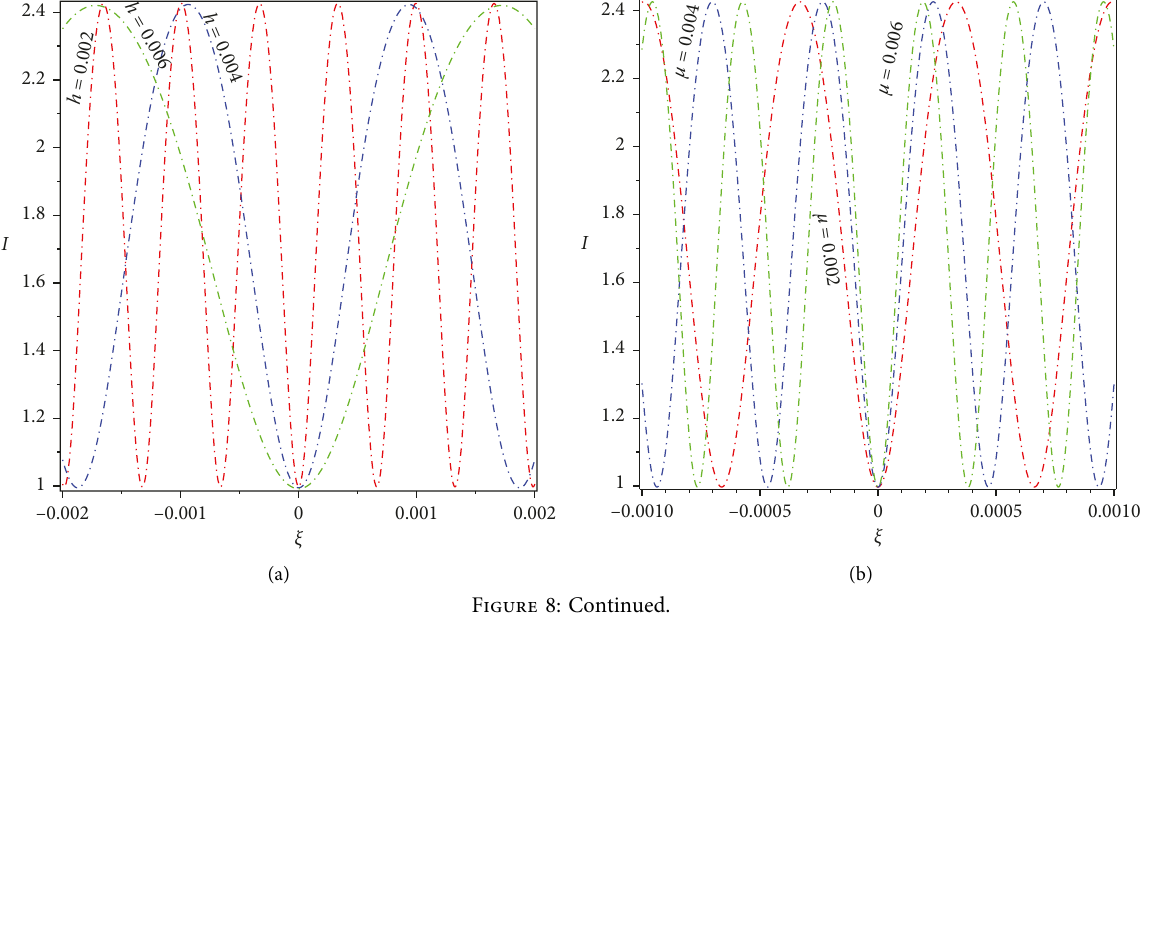
0 . 2 , ρ 0 . 1 , and σ (cid:31) (cid:31)